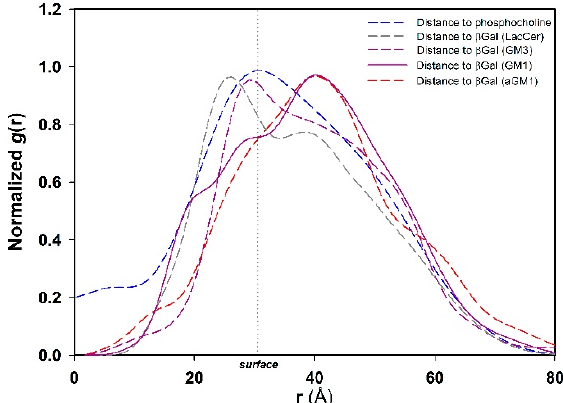
Figure 8. Radial distribution function, g(r), for all bilayers using g(r) to phosphocholine (PC) residue as reference. For bilayers 1, 3, and 4, g(r) was calculated from the center of mass of all lipid atoms to the terminal β -Gal residue, whereas non-terminal β -Gal residue was selected for bilayer 3.